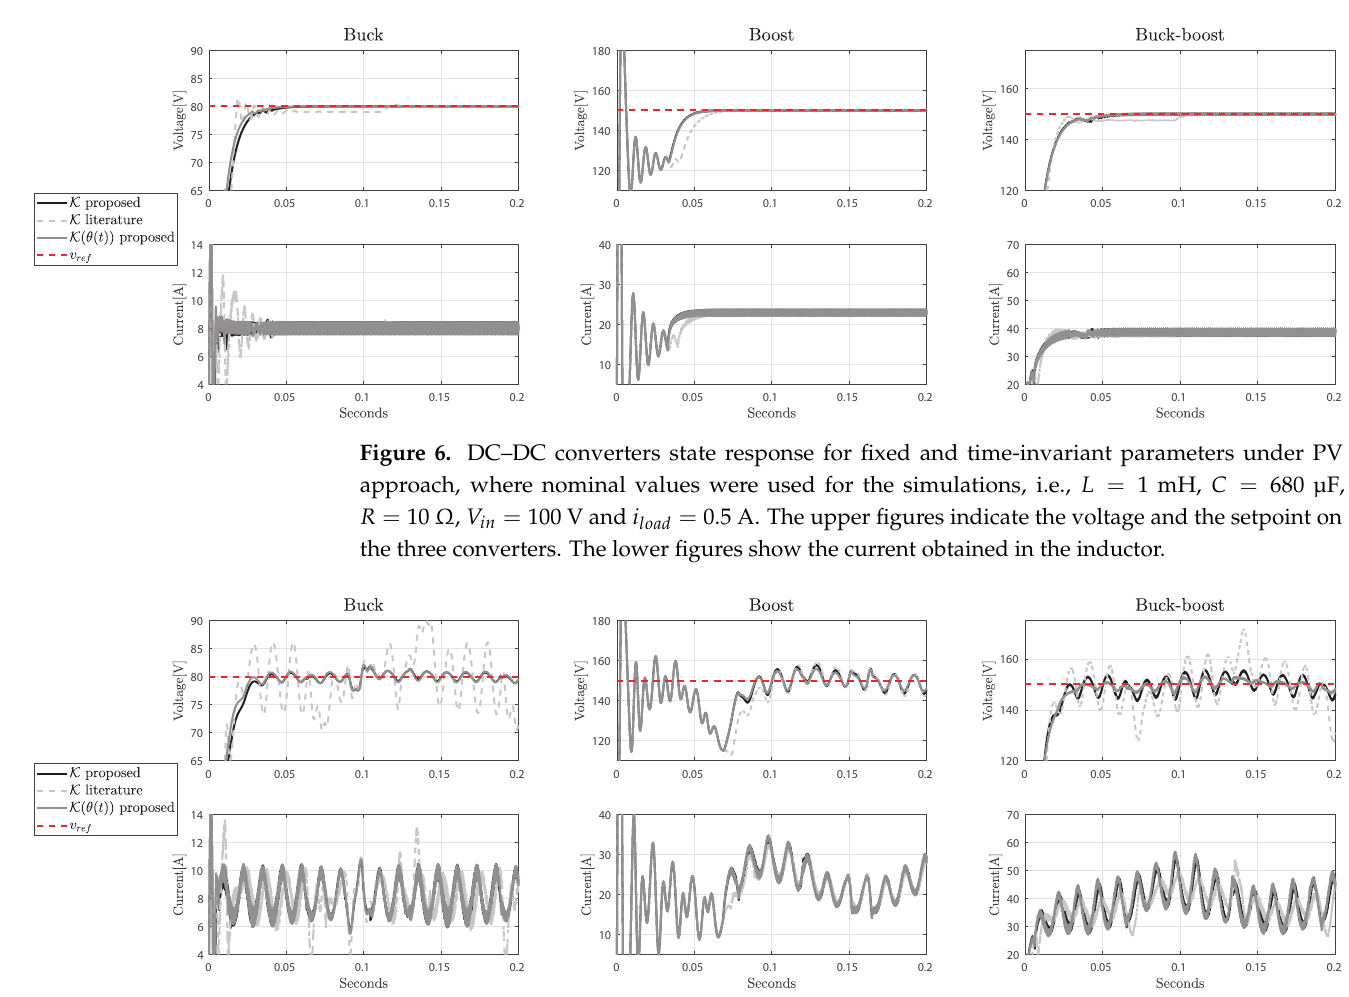
Figure 7. DC–DC converters state response for time-varying bounded parameters assumed to vary according to: R ( t ) = 10 + 2 · sin ( 500 t ) Ω , i load ( t ) = 0.5 · sin ( 1000 t ) A, L ( t ) = 1 + 0.2 · sin ( 400 t ) mH, C ( t ) = 680 + 136 · sin ( 300 t ) µF and V in ( t ) = 100 + 20 · sin ( 50 t ) V. The upper figures indicate the voltage and the setpoint on the three converters. The lower figures show the current obtained in the inductor.